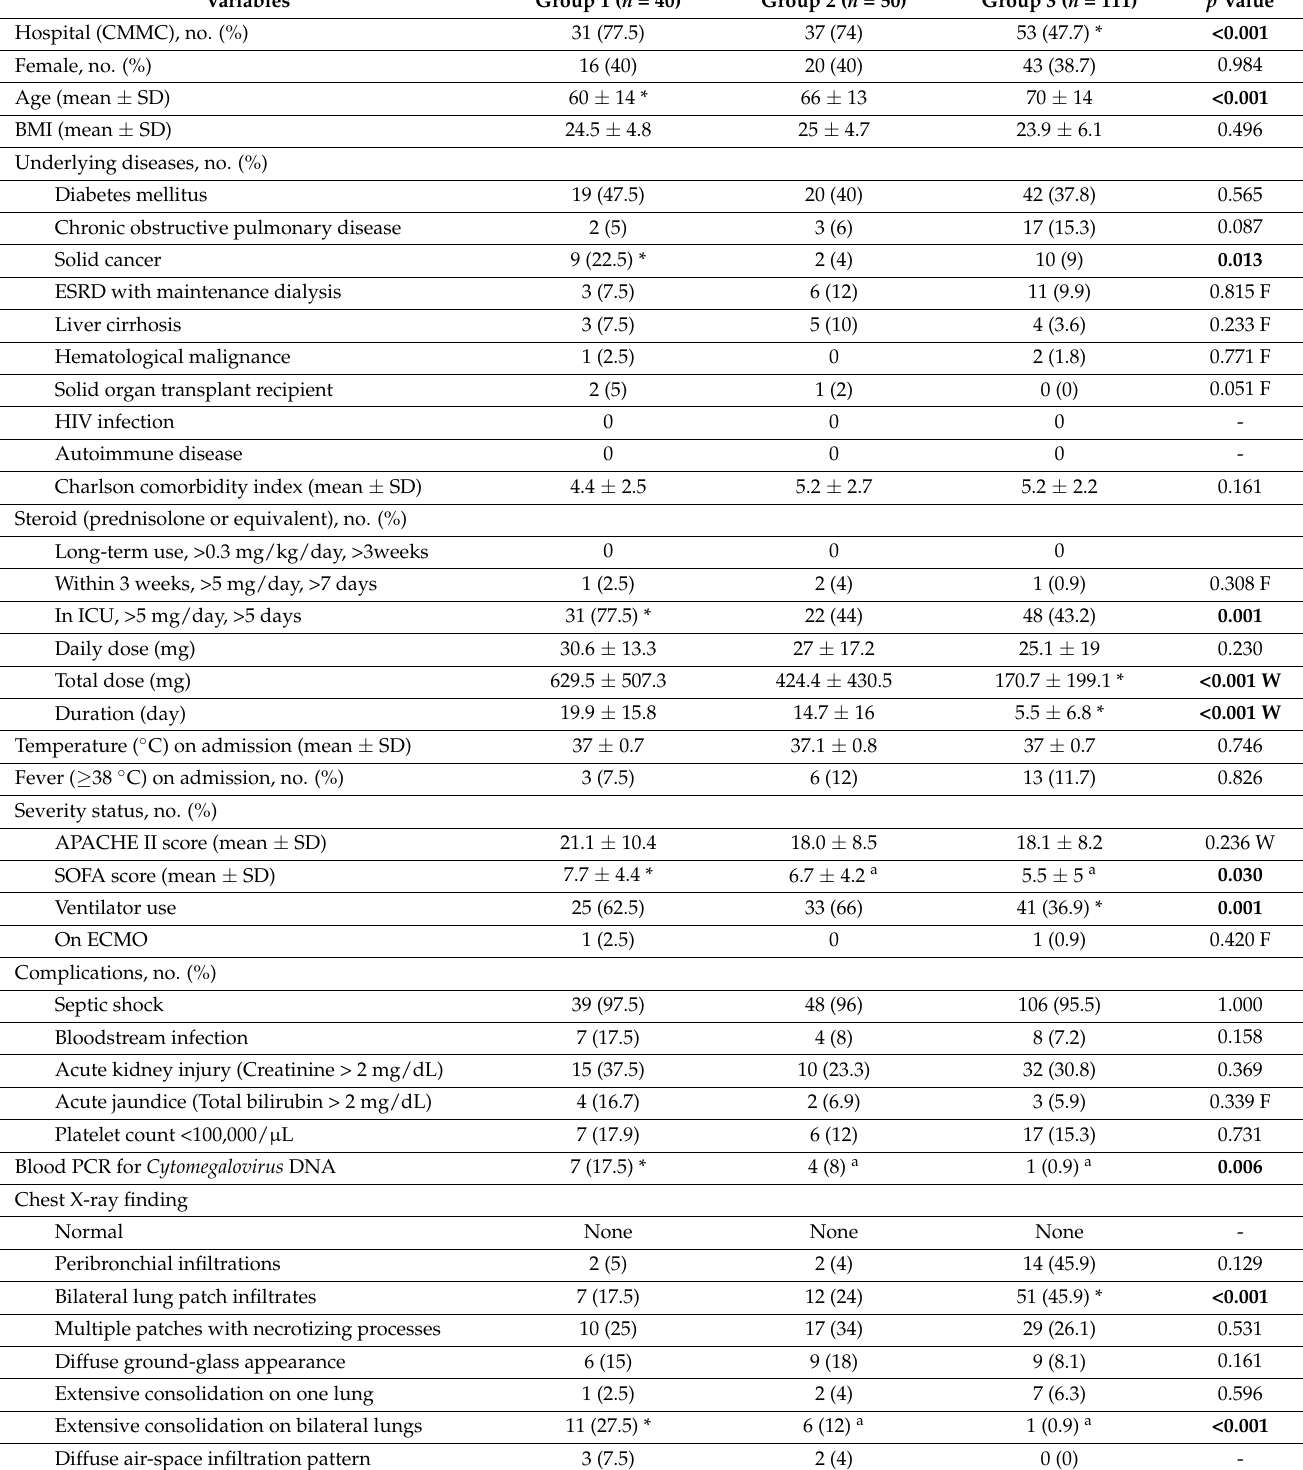
statistically significant difference in comparison to those of group 2, except for hospital distribution, total dosage, and duration of corticosteroid use (Table 1). Table 1. Clinical characteristics of ICU patients with severe influenza in comparison among those with aspergillosis (group 1), negative galactomannan assay (group 2), and non-testing for galactomannan (group 3). Variables Group 1 ( n = 40) Group 2 ( n = 50) Group 3 ( n = 111) p Value Hospital (CMMC), no. (%) 31 (77.5) 53 (47.7) *